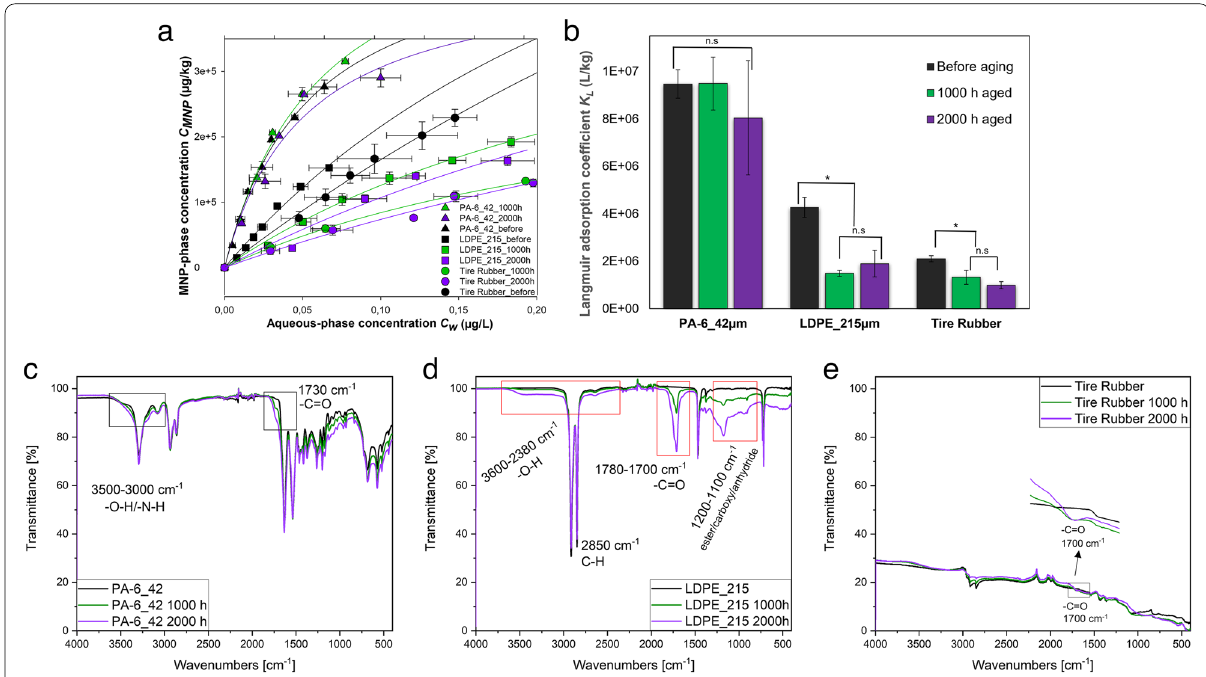
Fig. 5 a Sorption isotherms for B[ a ]P and UV-aged and non-aged MNPs ( n Corresponding Langmuir adsorption coefficients K L (error bars represent the standard errors of K L ). FTIR spectra of aged and non-aged ( c ) PA-6_42, ( d ) LDPE_215 and ( e ) Tire Rubber particles (*: significantly different ( p < 0.05), n.s.